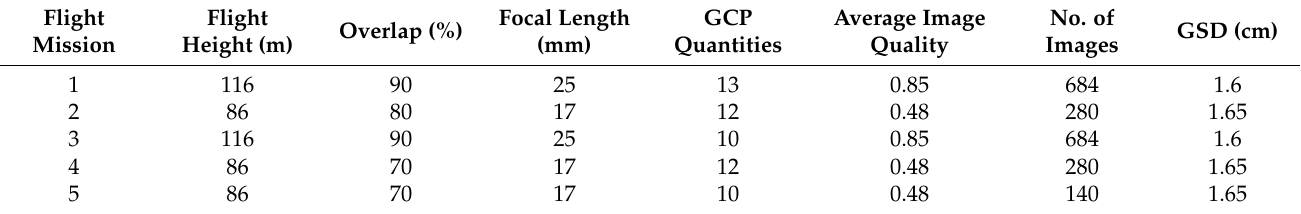
Table 5. Detailed Flight Configurations for Data